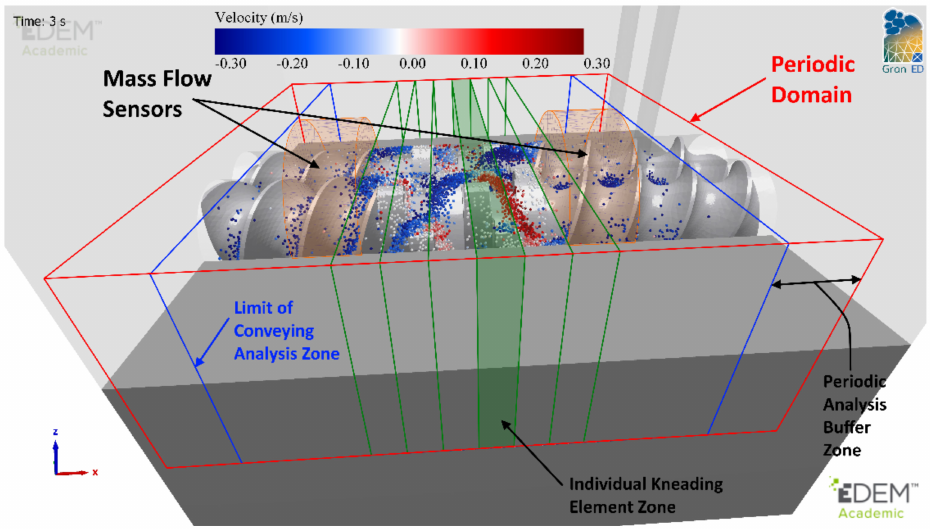
Figure 5. Periodic simulation zones at steady